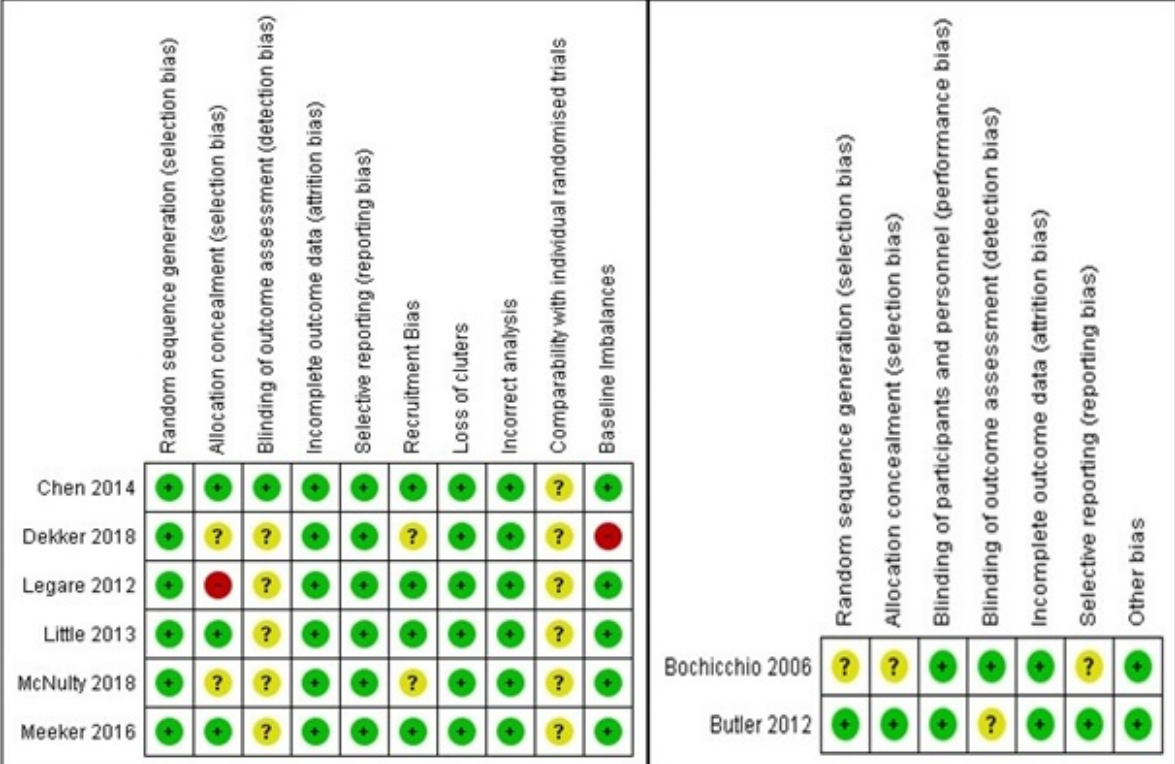
Figure 4. Risk of bias summary. Green: high risk of bias; red: low risk of bias; yellow: unclear risk of